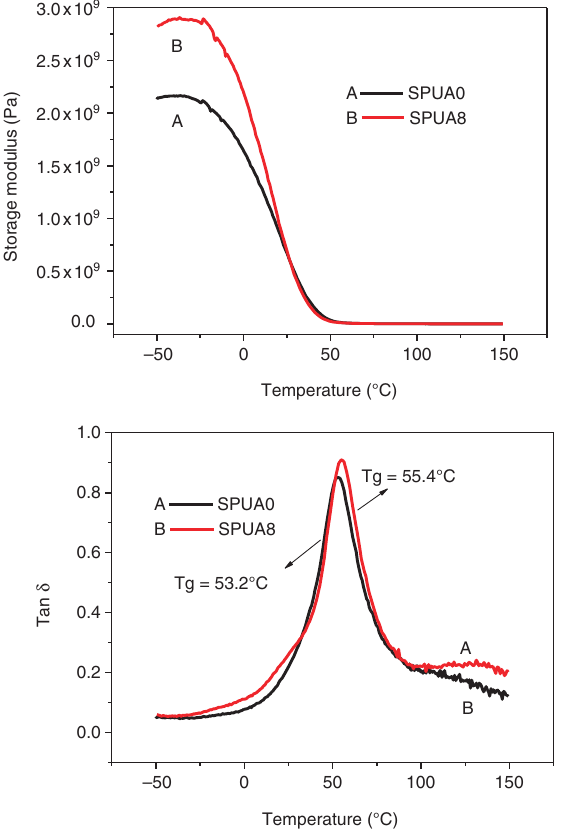
Figure 9: Storage modulus and tan δ curves for SPUA0 and SPUA8 composite films.